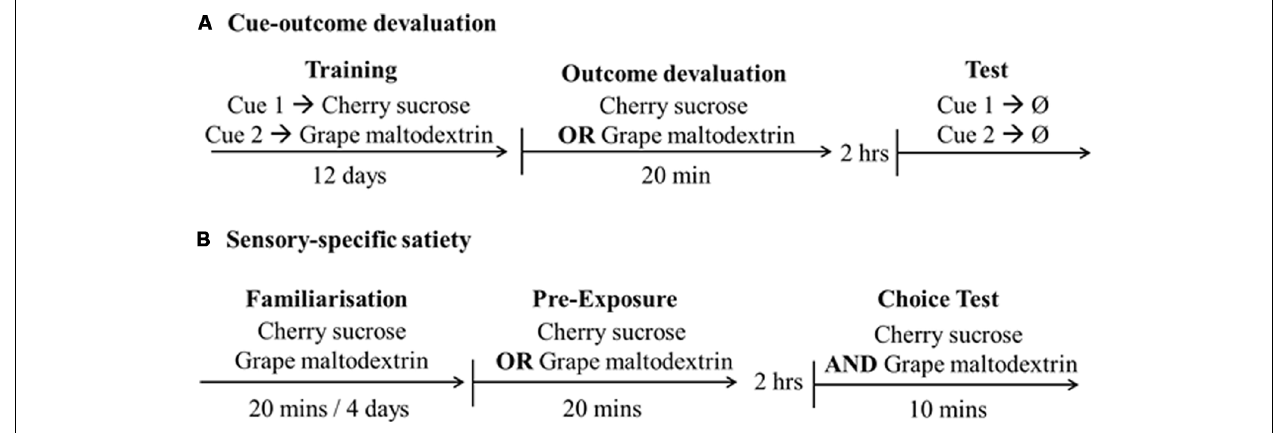
FIGURE 1 | Design and timeline of the studies. (A) Cue-outcome devaluation and (B) Sensory-specific satiety, indicating outcomes [cherry sucrose, grape maltodextrin, or no reward (Ø)].